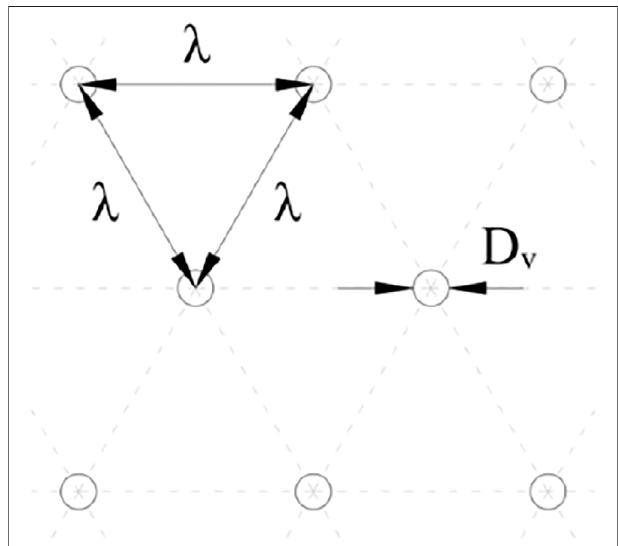
FIGURE 3 | Arrangement of vegetation stems.